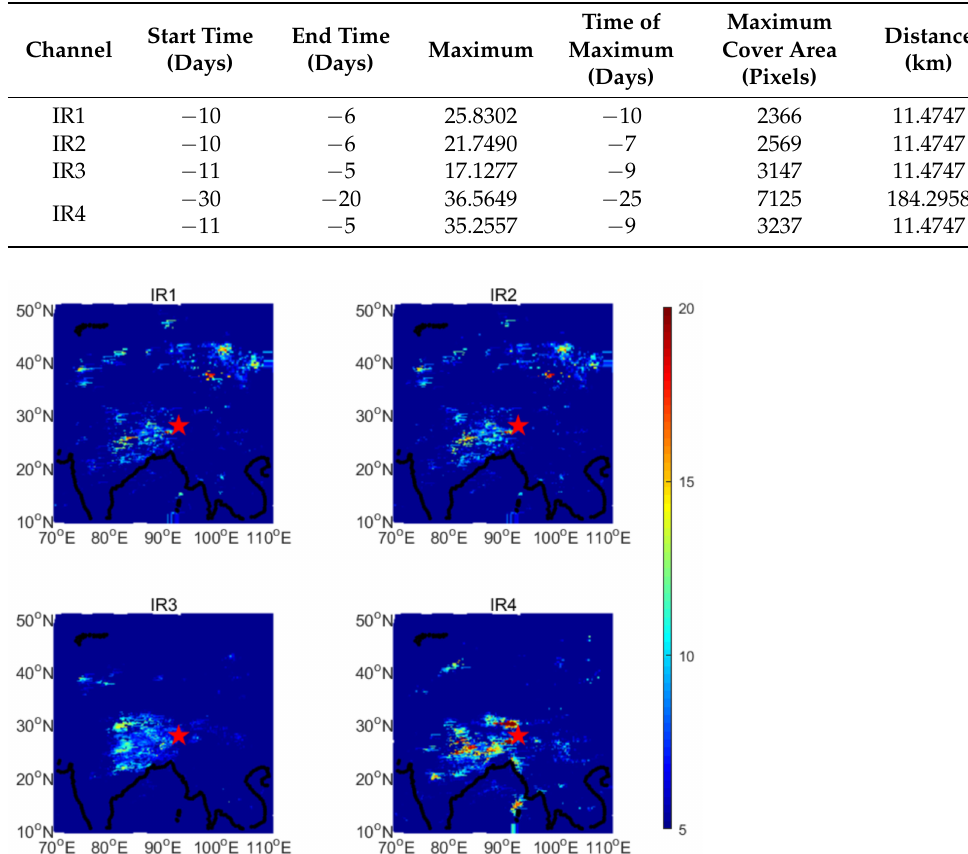
Table 5. The spatial–temporal characteristics of anomalies before the Tibet earthquake.